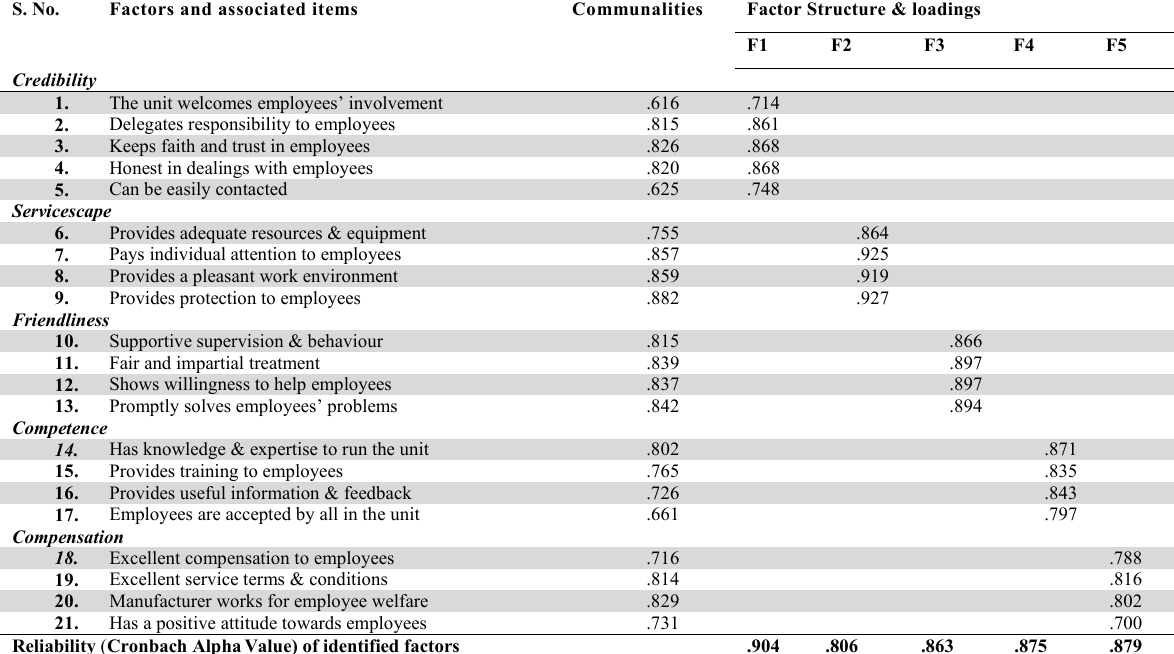
Communalities, Factor Structure and Loadings for items of Scale for measuring ISQ